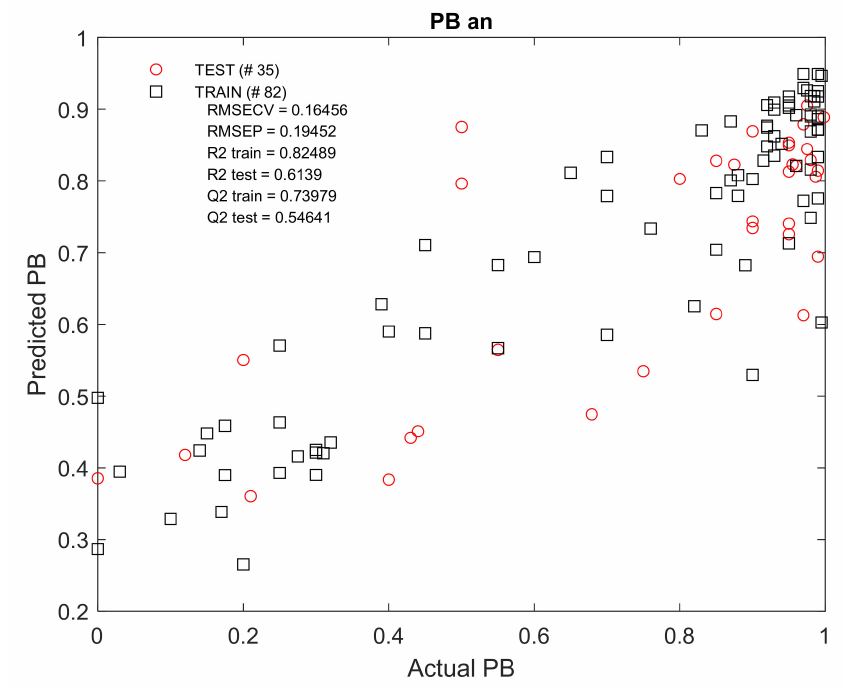
Figure A7. Actual versus predicted PB an values, using RF regression modelling of molecular descrip- tor set containing 23 variables along with NP TLC